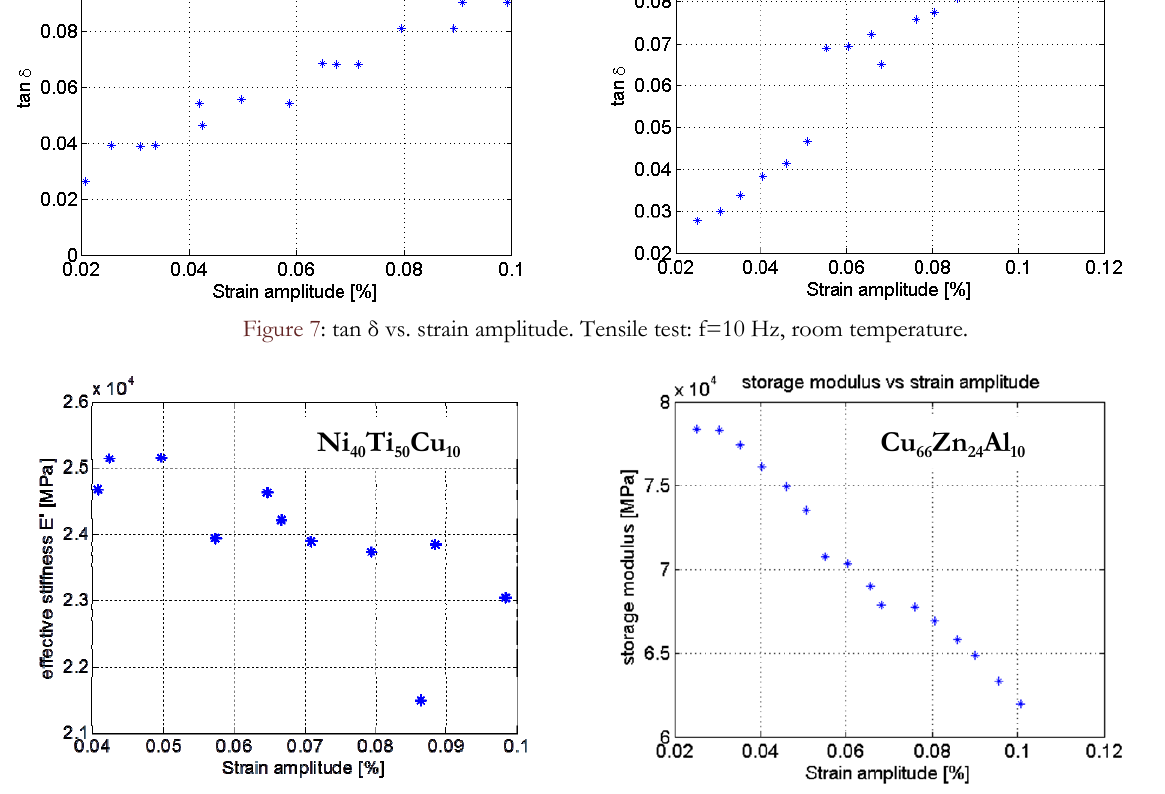
Figure 8: Storage modulus vs. strain amplitude. Tensile test: f=10 Hz, room temperature.